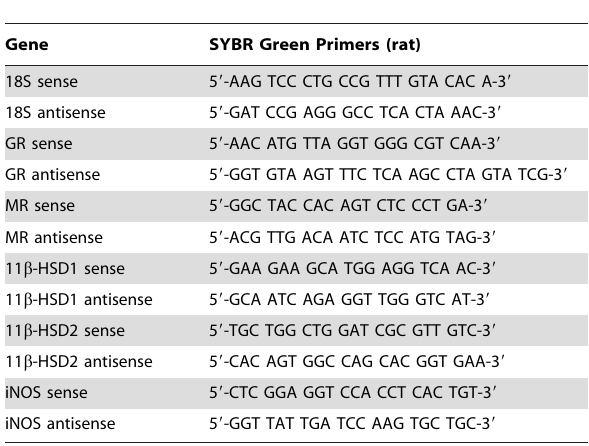
Table 1. Real-time PCR primers.